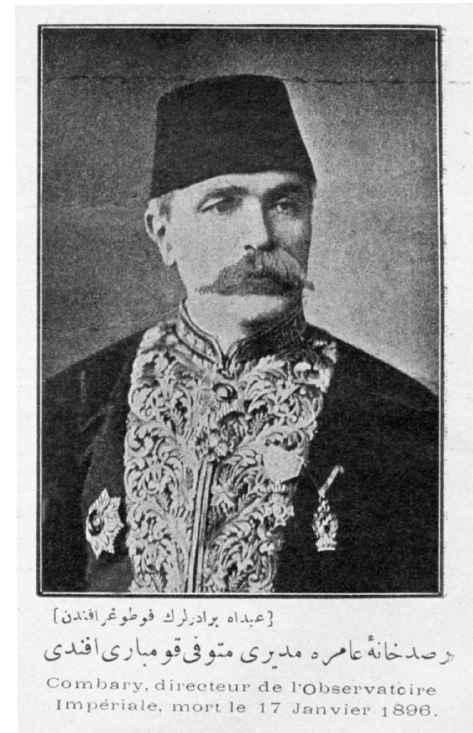
Figure 3. Aristid